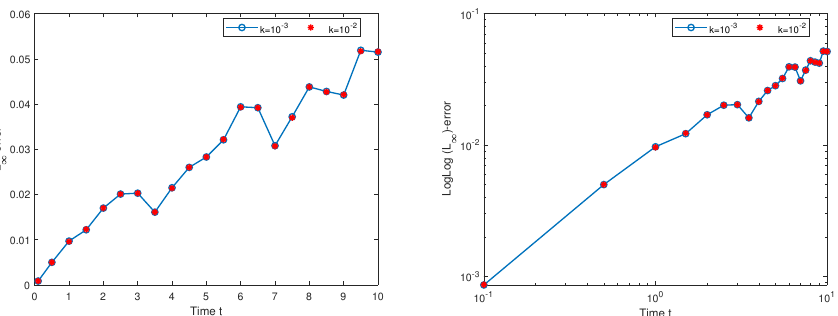
Figure 6. Plots of the maximum error vs. time t ∈ [ 0,10.0 ] and the loglog plot of max. error vs. time using the classical FDM for Experiment 1 with ∆ t = 0.001, 0.01 and ∆ x = π